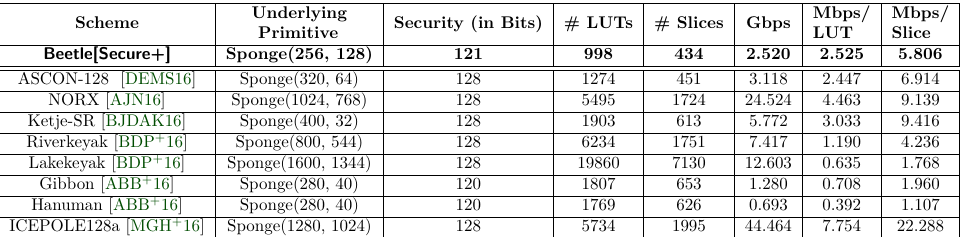
Table 7: Benchmarking Beetle[Secure+] on Virtex 6.